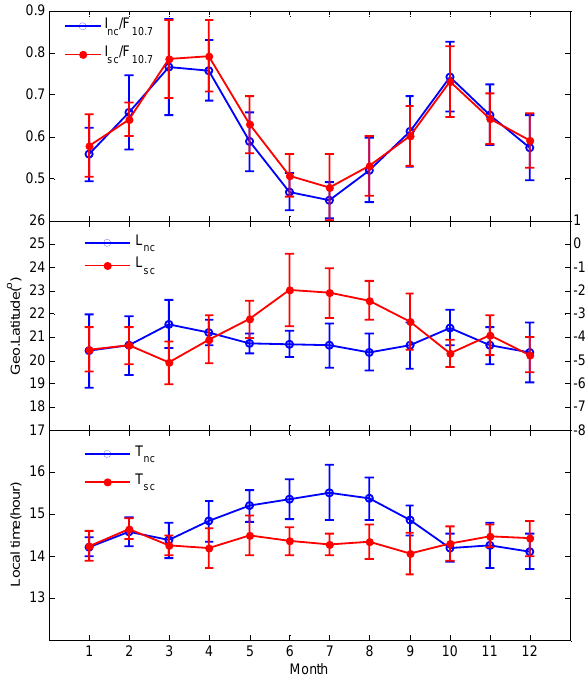
Figure 4. Panels from top to bottom show monthly mean values over the 9 years of equivalent crest value per solar flux unit ( I/F 10.7 ), occurrence of geographic latitude ( L ), and occurrence of local time ( T ) for the northern ( nc ) and southern ( sc ) EIA crest. Vertical bars indicate one standard deviation.